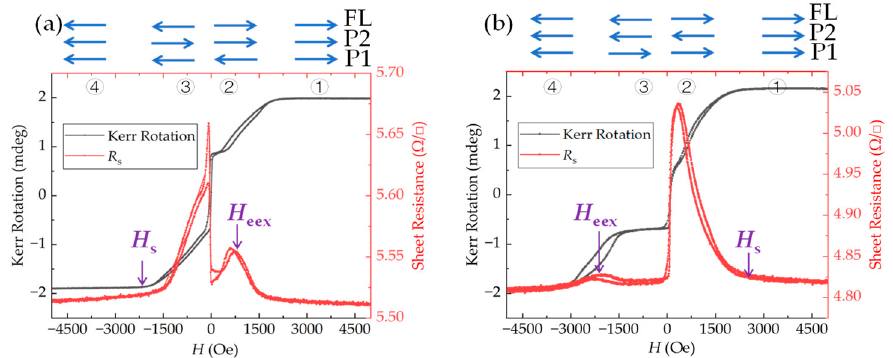
Figure 2. Magnetization loops (black line, left Y -axis) and R s - H loops (red line, right Y -axis) of the film with different NiFeCr thicknesses: ( a ) t NiFeCr = 8.2 nm; ( b ) t NiFeCr = 15.3 nm.